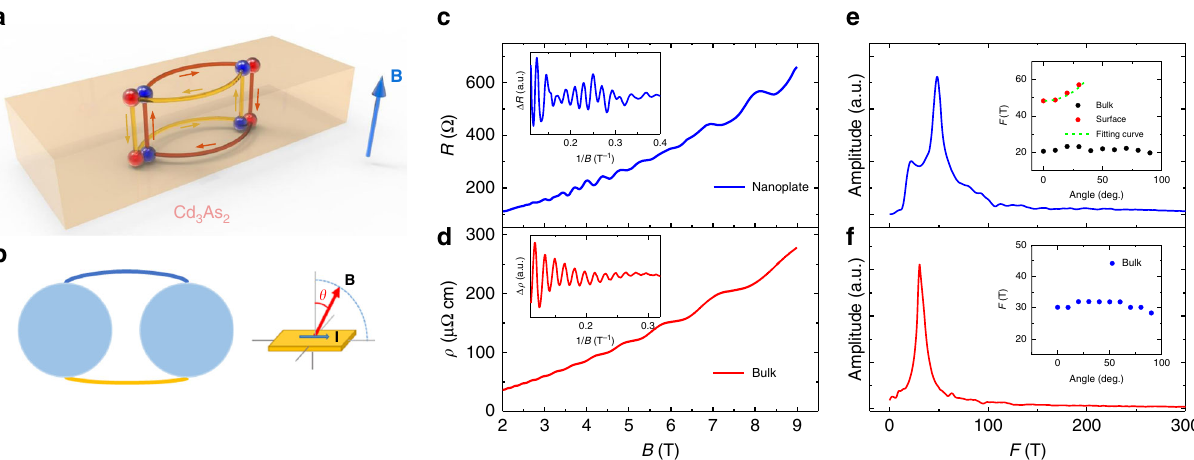
Fig. 1 Formation of Weyl orbits and new 2D Fermi surface in Cd 3 As 2 nanoplates. a Illustration of Weyl orbits in Cd 3 As 2 with the magnetic fi eld perpendicular to the sample surface. Each set of Weyl orbit consists of two half cyclotron processes in the momentum space of the top and bottom surfaces and a real-space propagation between surfaces. The two ends of Fermi arcs connect bulk Weyl node pairs with the opposite chirality (red and blue). b Illustration of Fermi surface when the Fermi energy is not at Dirac points (left) and the geometry of magnetotransport measurement setup (right). The two Fermi surfaces are connected by the two Fermi arcs. θ is de fi ned as the angle between magnetic fi eld and the normal direction of the sample surface. c , d Comparisons of MR in Cd 3 As 2 nanoplate (sample #1, c ) and Cd 3 As 2 bulk crystals d , respectively. The insets in c and d are the extracted oscillations in sample #1 and Cd 3 As 2 bulk crystals, respectively. e , f Comparisons of the FFT spectra of quantum oscillations in sample #1 e and Cd 3 As 2 bulk crystals f , respectively. The insets in e and f are the angle dependence of oscillation frequency in sample #1 and bulk Cd 3 As 2 crystals,